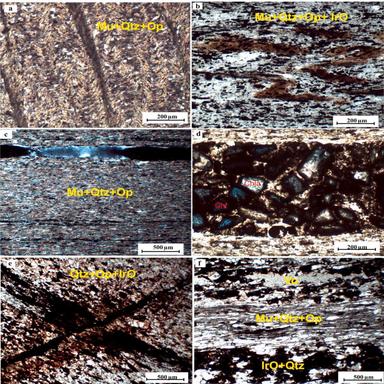
Textural and mineralogical aspects of phyllites in petrographic thin sections. Images b, c, d, e, and f show the main weathering alteration effects of opaque minerals and chlorites, in which abbreviations mean: IrO iron oxides/hydroxides, Mu muscovite, Op opaque minerals, Qtz quartz, and Vo voids. (a) Crenulation cleavage given by muscovite and sericite (phyllite W1/W2). (b) Precipitation of iron oxides/hydroxides due to the weathering of opaque minerals (phyllite W1/W2). (c) Altered fracture parallel to th